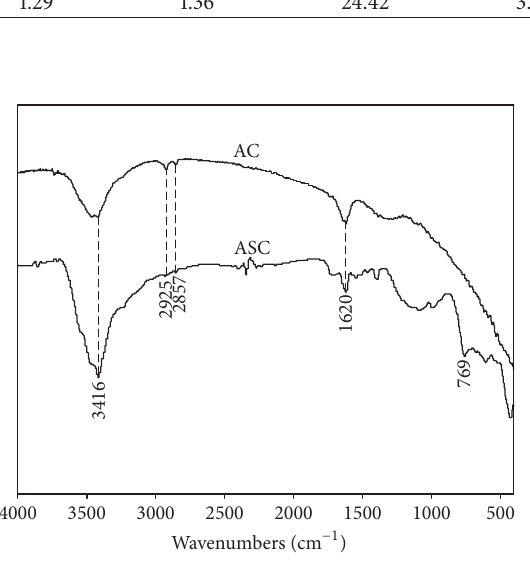
Figure 1: FTIR spectra of the AC and ASC.